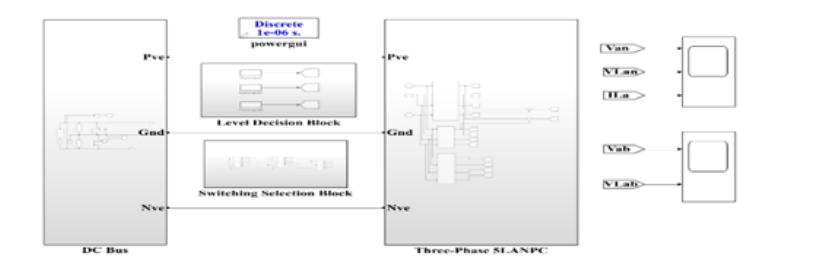
Fig.3. 5LANPC with proposed control strategy using Simulink